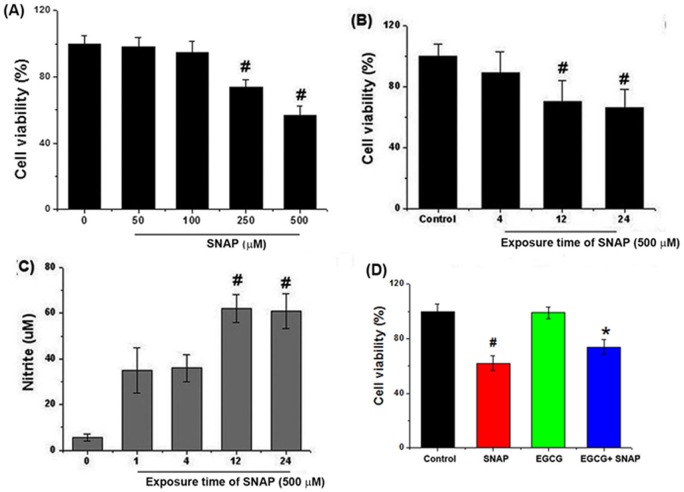
Effects of EGCG on NO-induced cell death in HEI-OC1 cells.(A, B) Cell viability evaluated by MTT colorimetric assay, as a function of SNAP concentration and exposure time. (C) Cells were treated with 500 μM SNAP for varying times, and NO levels were determined by the measurement of nitrite based on the Griess reaction. (D) Cells were pretreated with 50 μM EGCG and then 500 μM SNAP for 24 h. Cell viability was evaluated by MTT assay. All data represent the mean ± SEM of 3 independent experiments (#P<0.05 vs. control, *P<0.05 vs. SNAP alone).